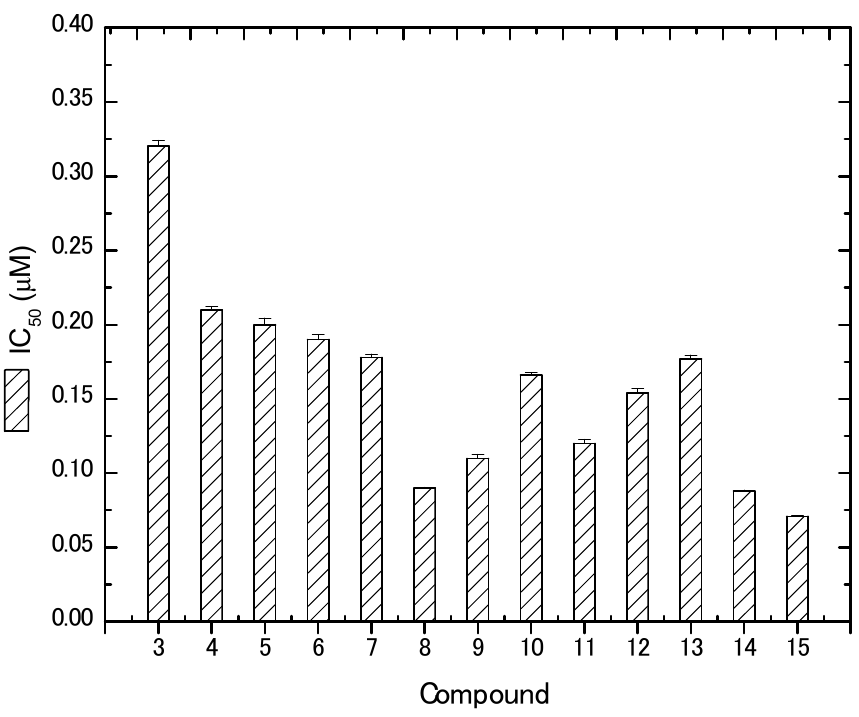
Figure 3. IC 50 of the tested compounds against pim-1 Kinase.